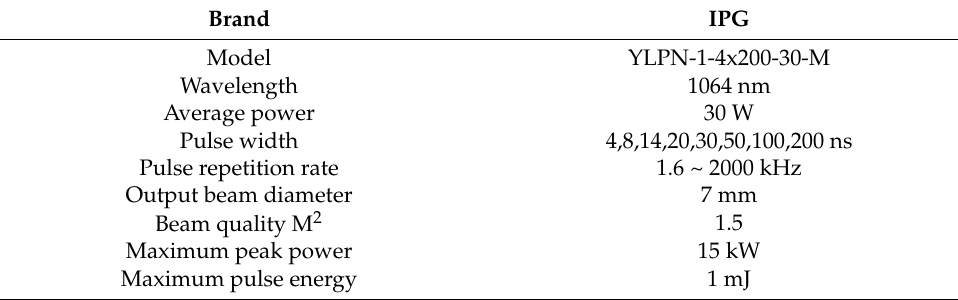
Table 2. Specifications of nanosecond fiber laser